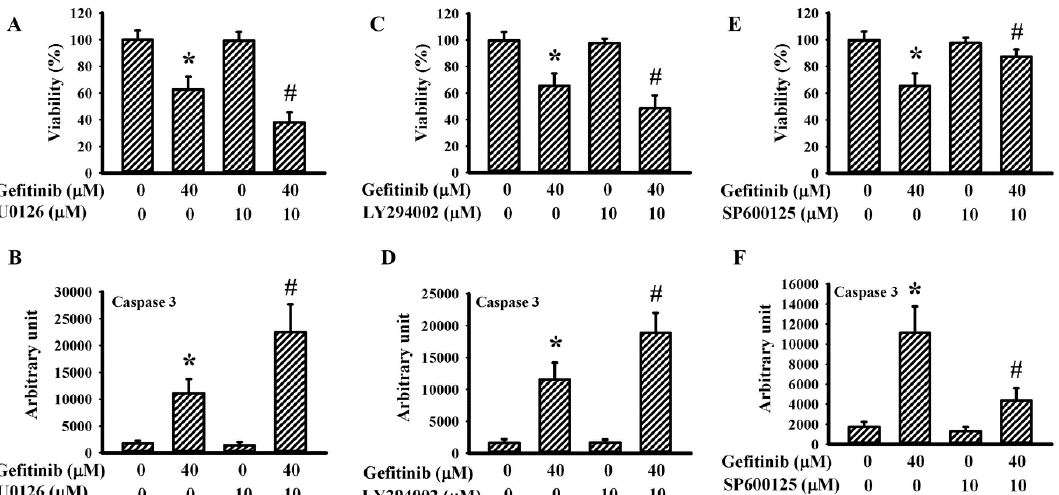
Figure 2. Pharmacological inhibitors altered gefitinib-induced apoptosis in H4 cells. H4 cells were treated with gefitinib (0 and 40 µ M) together, with or without U0126 (10 µ M, A , B ), LY294002 (10 µ M, C , D ), or SP600125 (10 µ M, E , F ). Cell viability (24 h) was measured with the alamarBlue assay ( A , C , E ). Caspase 3 activity (6 h) was measured with enzymatic assay ( B , D , F ). * p < 0.05 vs. untreated control and # p < 0.05 vs. gefitinib (40 µ M), n = 4.